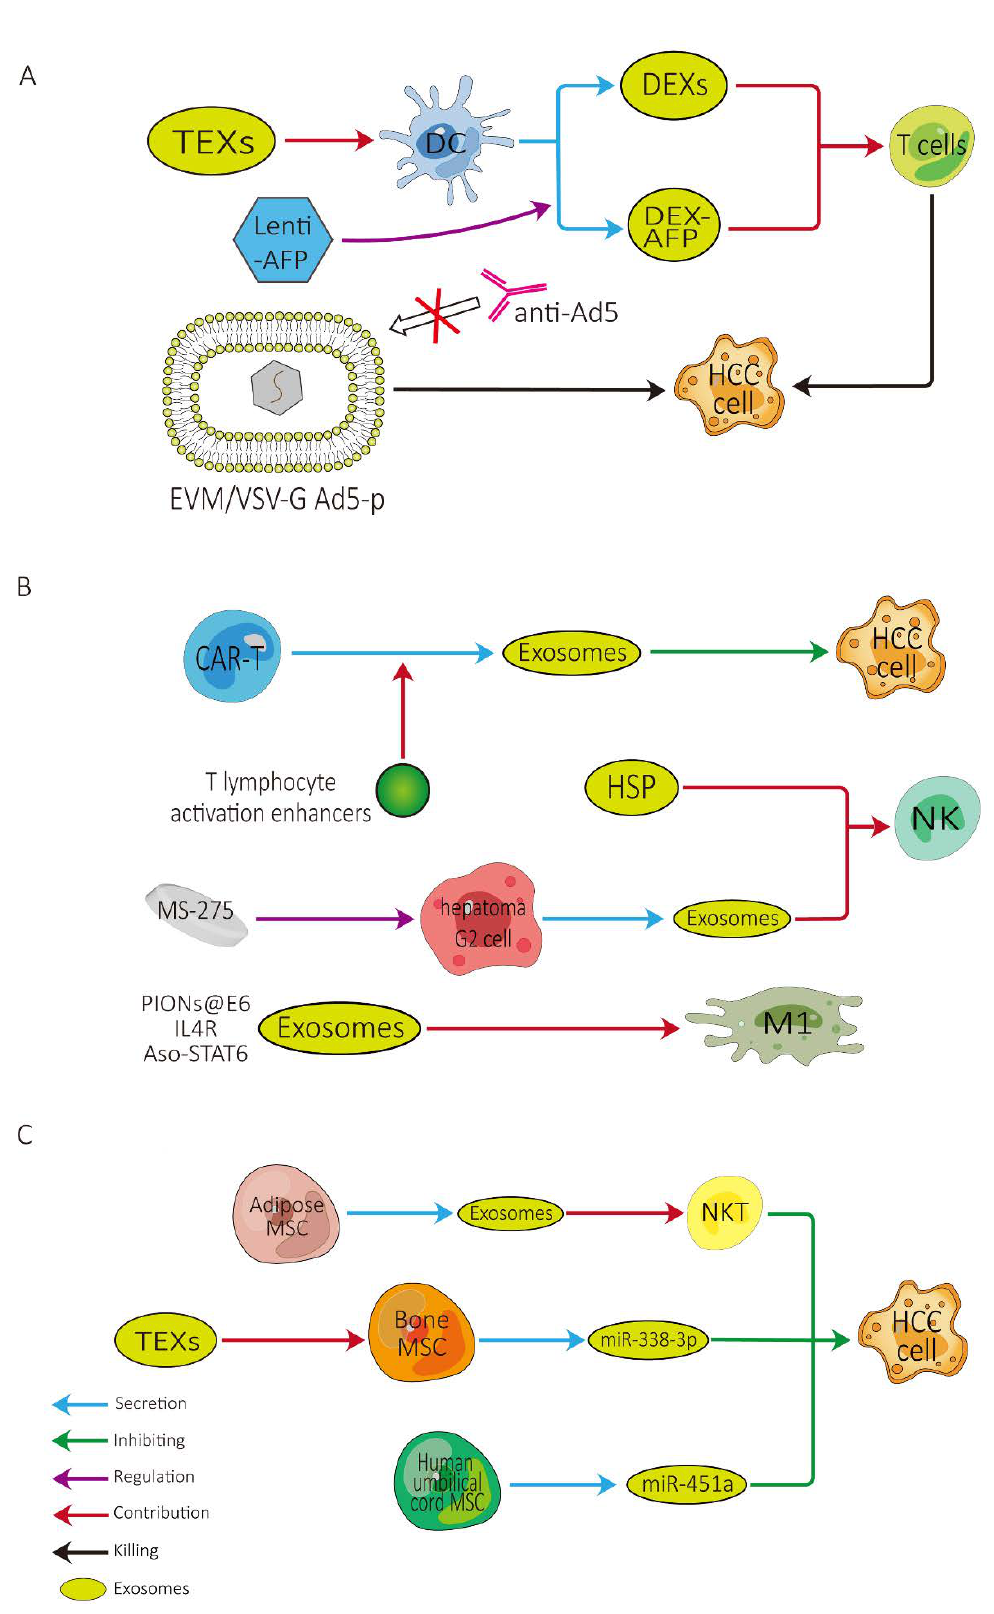
Figure 4. Potential role of exosomes in improving the efficacy of ( A ) tumor vaccine therapy; ( B ) adop- tive cell therapy; and ( C ) mesenchymal stem cell therapy. HCC, hepatocellular carcinoma; TEXs, tumor-cell-derived exosomes; DEX, DC-derived exosomes; DEX-AFP, exosomes derived from AFP- expressing DCs; CAR-T, chimeric antigen receptor T; HSP, heat shock protein; NK, natural killer cell; M1, M1-polarized macrophage; MSC, mesenchymal stem cell; NKT, natural killer T